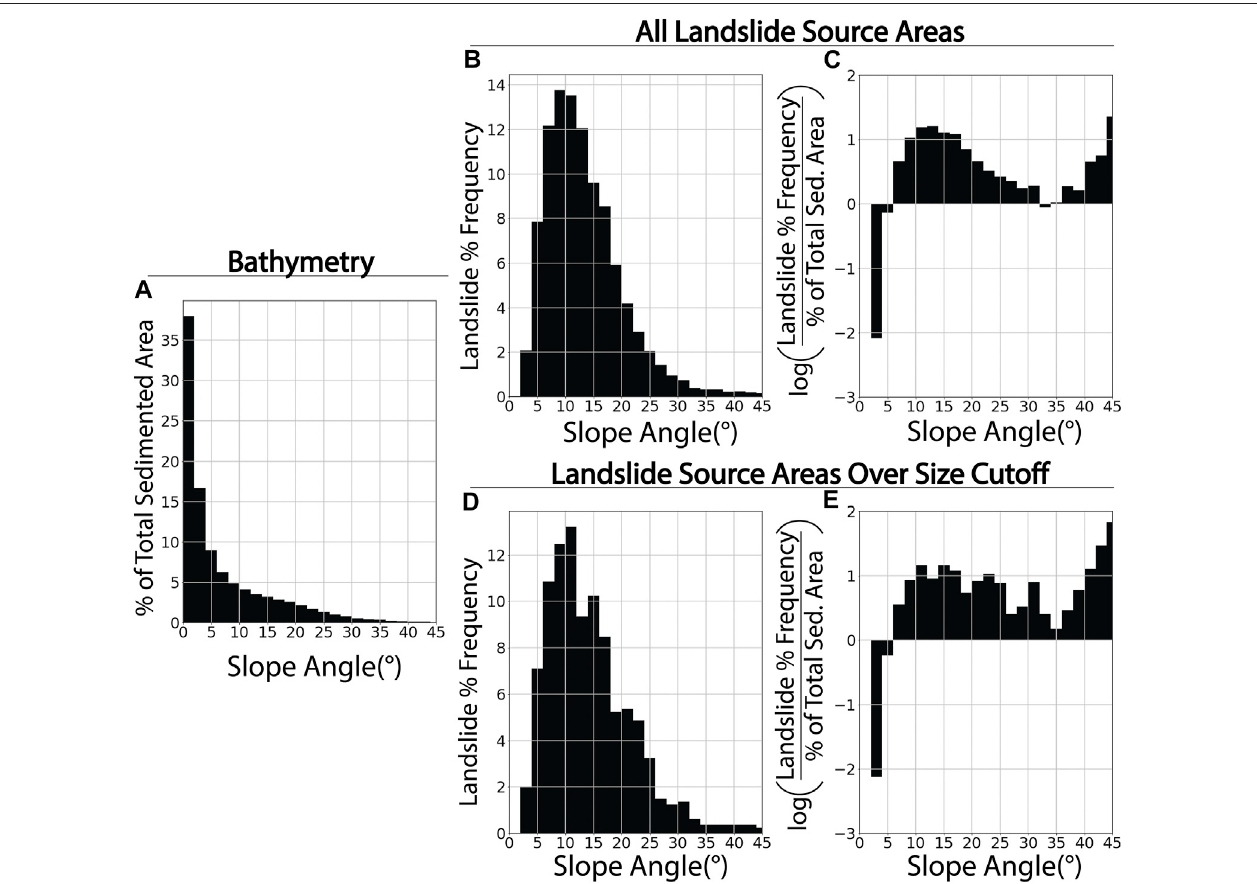
FIGURE 8 | (A) Slope angle distribution of sedimented areas for Glacier Bay bathymetric data, expressed as a percentage of total sedimented area in the bathymetric data. (B, D) Landslide slope angle plotted against frequency of landslide occurrence (expressed as a percent of total number of landslides), shown for all landslides in the inventory (Plot B), and for landslides above the threshold values in this study (Plot D). Slope angle for each landslide was calculated as the mean slope angle in a 25 m buffer upslope of the scarp. (C, E) Slope angle frequency of landslides normalized for total slope area, expressed as the natural log of the ratio of landslide frequency (% of total landslide) to the area of bathymetric data at that slope angle (% of total area), shown for all landslides in the inventory (Plot C) and for landslides above the threshold values in this study (Plot E). Values in Plot E represent the slope-based susceptibility index (SI slope ) in the fi nal susceptibility maps. No landslides were observed in the 0 – 2 ° slope